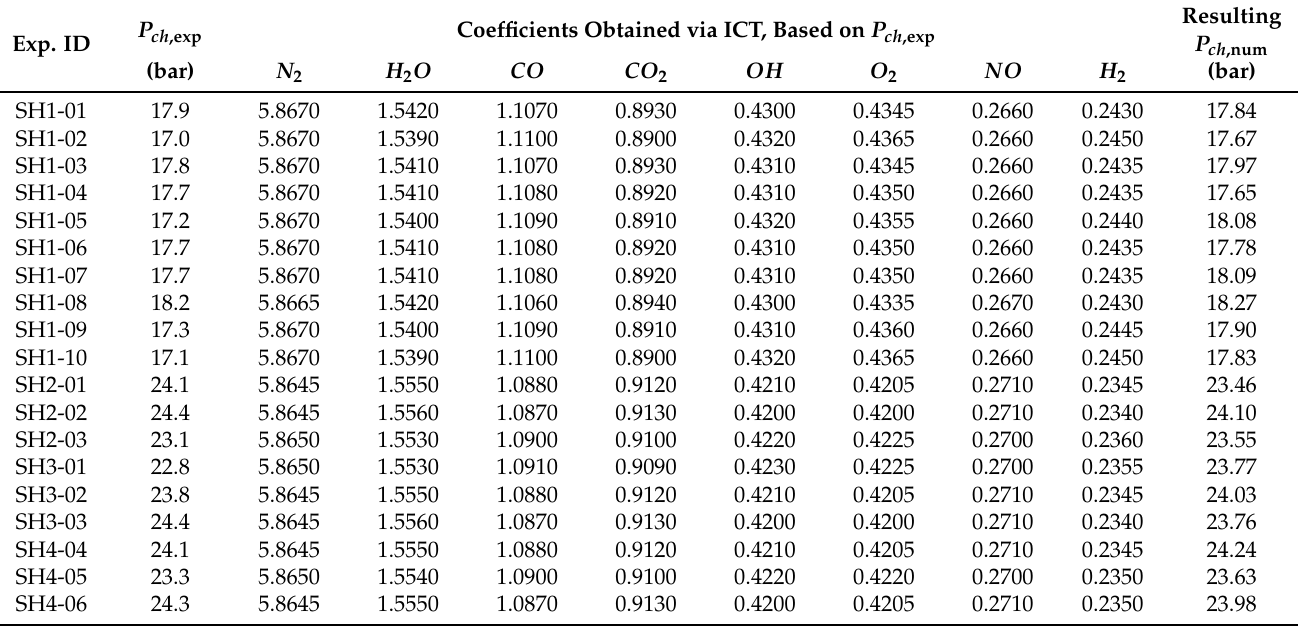
Table 8. Summary of the product stoichiometric coefficients for the 19 simulations.